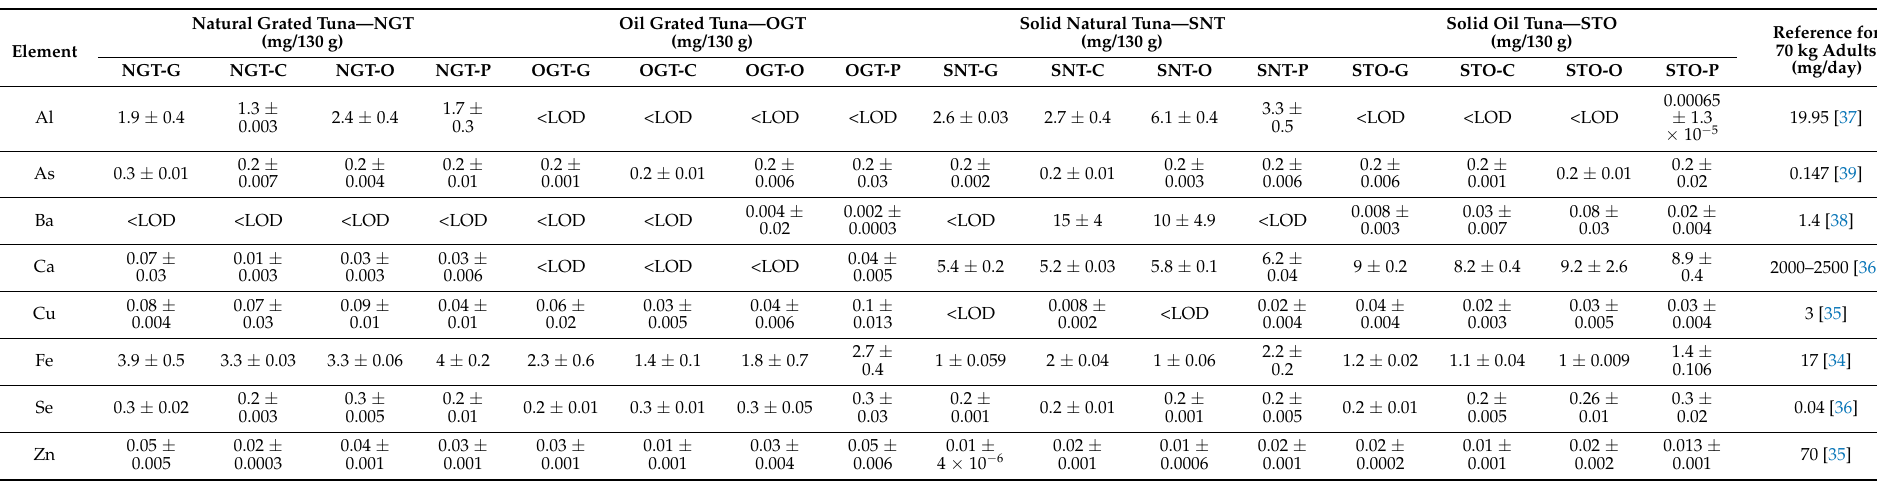
Note: <LOD—analyte concentration below the limit of detection; ND = not